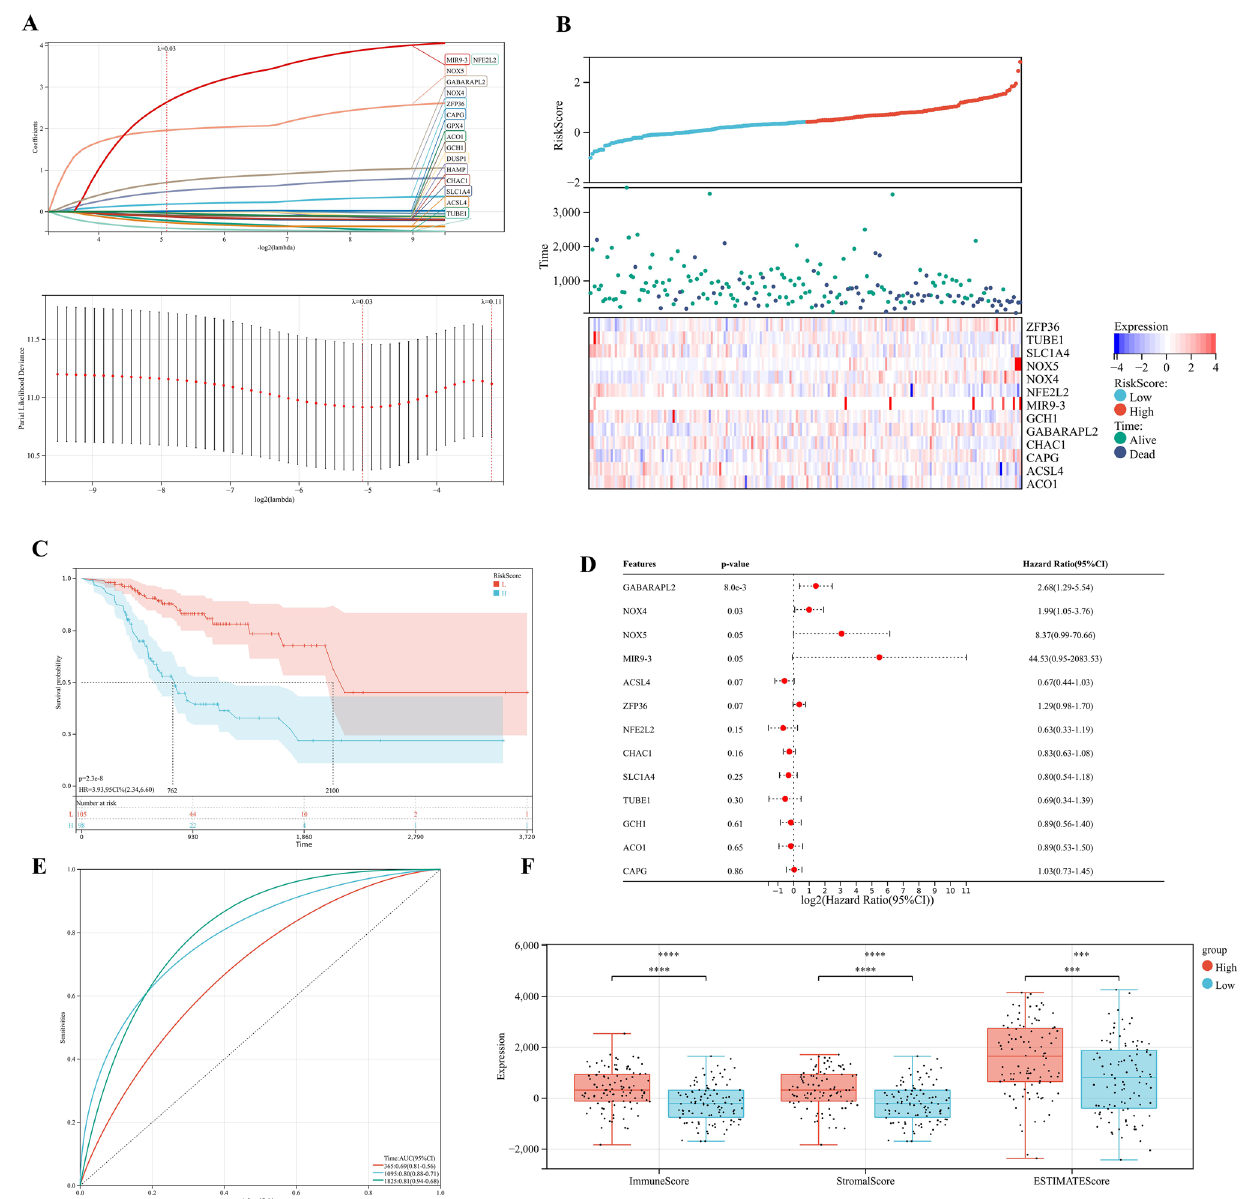
Figure 4. Establishment of prognostic risk signature based on FRPGs in the training cohort. ( A ) LASSO analysis with suitable lambda. ( B ) Distribution of survival status, risk score, and heatmap of GC patients in the high and low risk groups. ( C ) Survival curve of the GC patients in the two groups. ( D ) Forest map of multi- factor survival analysis. ( E ) Time-dependent ROC curve of the risk signature. ( F ) Stromal score, Immune score, and ESTIMATE score in the high and low risk groups (* p < 0.05; ** p < 0.01; *** p < 0.001). ( G ) Correlation between the FRPGs and the infiltration level of immune cells in TIMER database. ( H ) Statistical analysis of immune related cells evaluated by CIBERSORT algorithm in the two groups (* p < 0.05; ** p < 0.01; *** p <